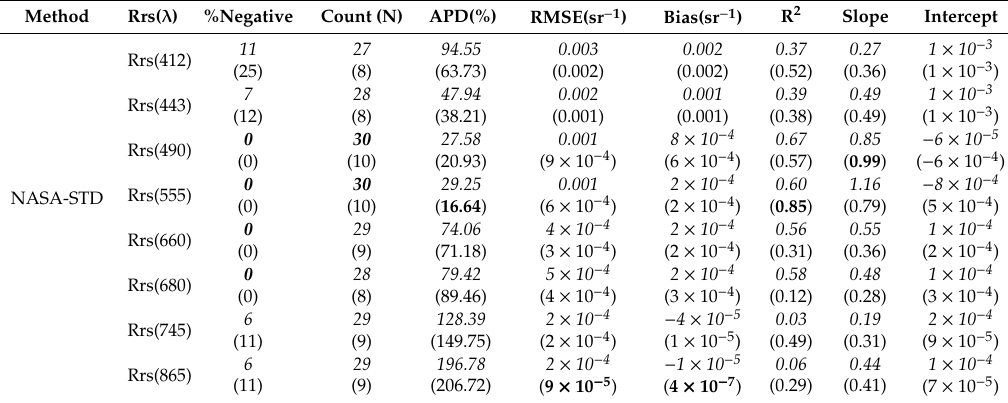
Table 1. Statistical results for GOCI-retrieved Rrs values obtained using the NASA-STD algorithm and the in situ Rrs comparison at 02:16, 03:16, and 04:16 UTC for ± 3 h (values in parentheses indicate results for ± 1 h). Percentages of negative retrievals (%) are given; these values were removed in the statistics. The italic numerals of each index represent ± 3 h, while the statistical results in parentheses are ± 1 h. APD: absolute percentage di ff erence, RMSE: Root Mean Square Error.